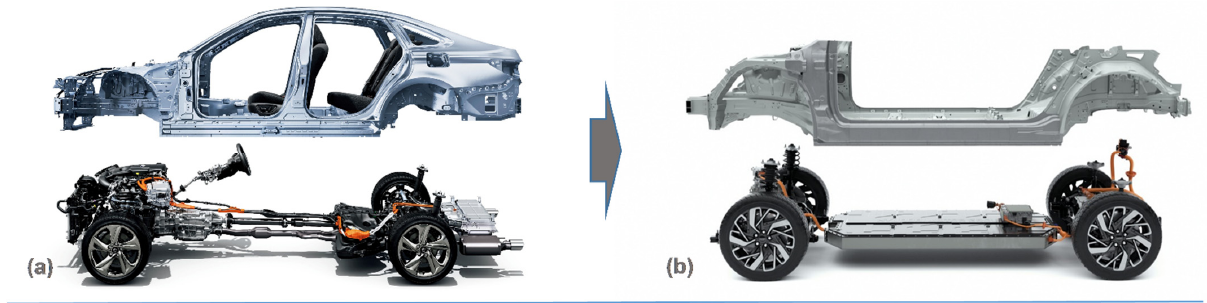
Figure 4. Architecture difference between internal combustion engine vehicles and battery electric vehicles: ( a ) ICE, Toyota Crown redesigned platform, 2018 [18], and ( b ) BEV, Hyundai/Kia/Genesis E-GMP platform, 2021 [19].